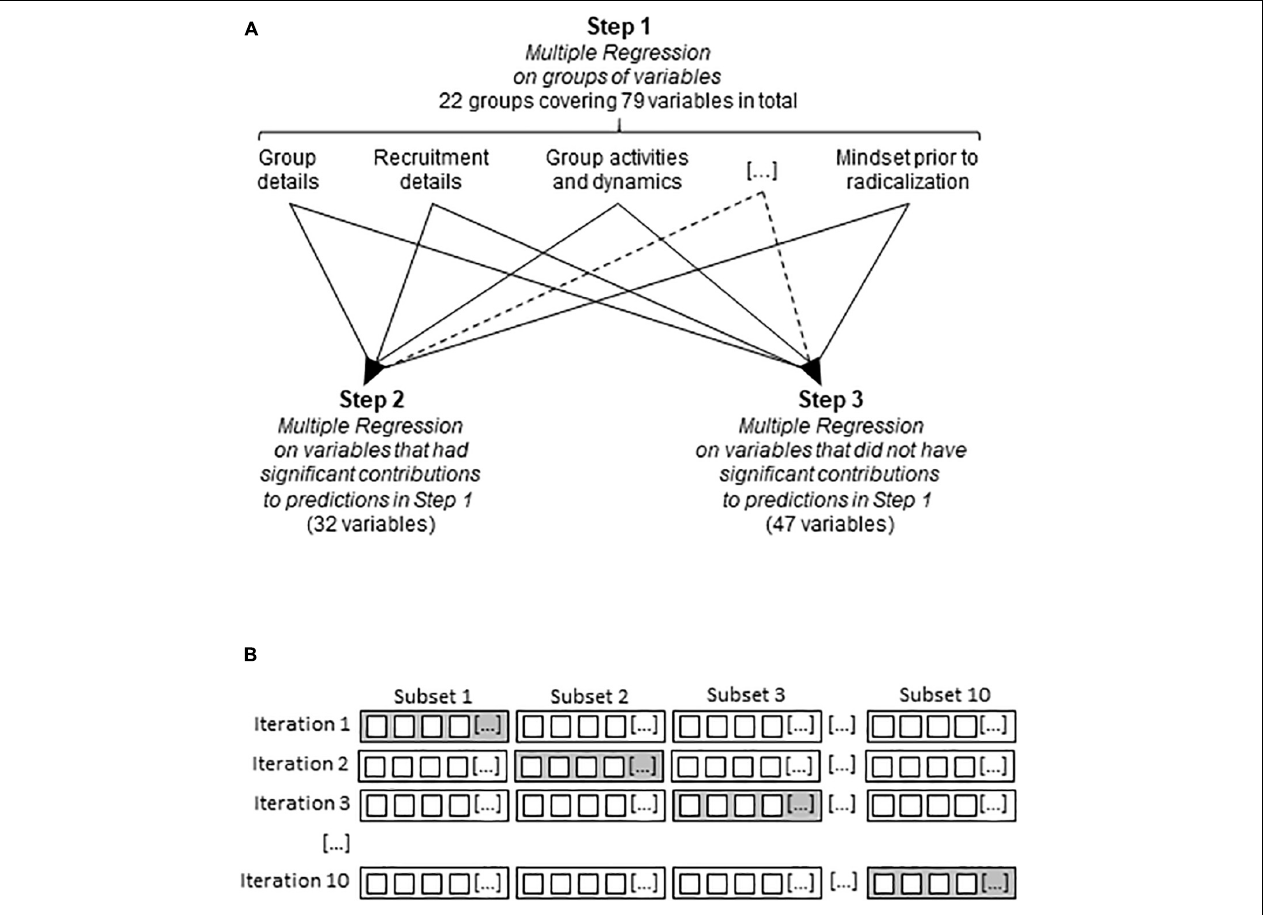
FIGURE 1 | Strategy employed in Multiple Regression and machine learning analyses. (A) The stepwise approach employed in Multiple Regression. Note that the sample size did not allow the evaluation of all 79 variables in one single analysis, which explains the stepwise approach. [ ... ], variables not shown. (B) The partition of the database into training and testing data subsets with the XGBoost algorithm. The small squares represent the extremists included in the PIRUS database; the larger rectangles demarcate data subsets. White, training subset; gray, testing subset; [ ... ], data subsets not